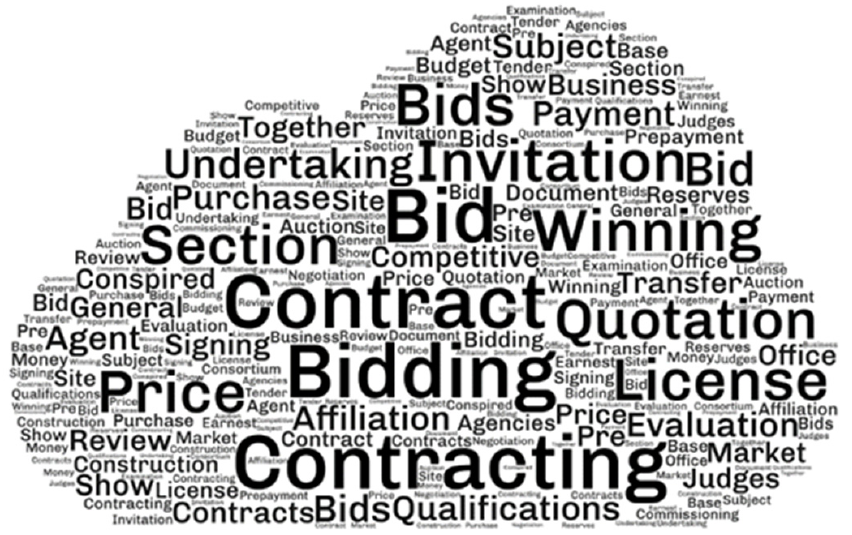
Figure 3. Word cloud of corruption link in bidding.